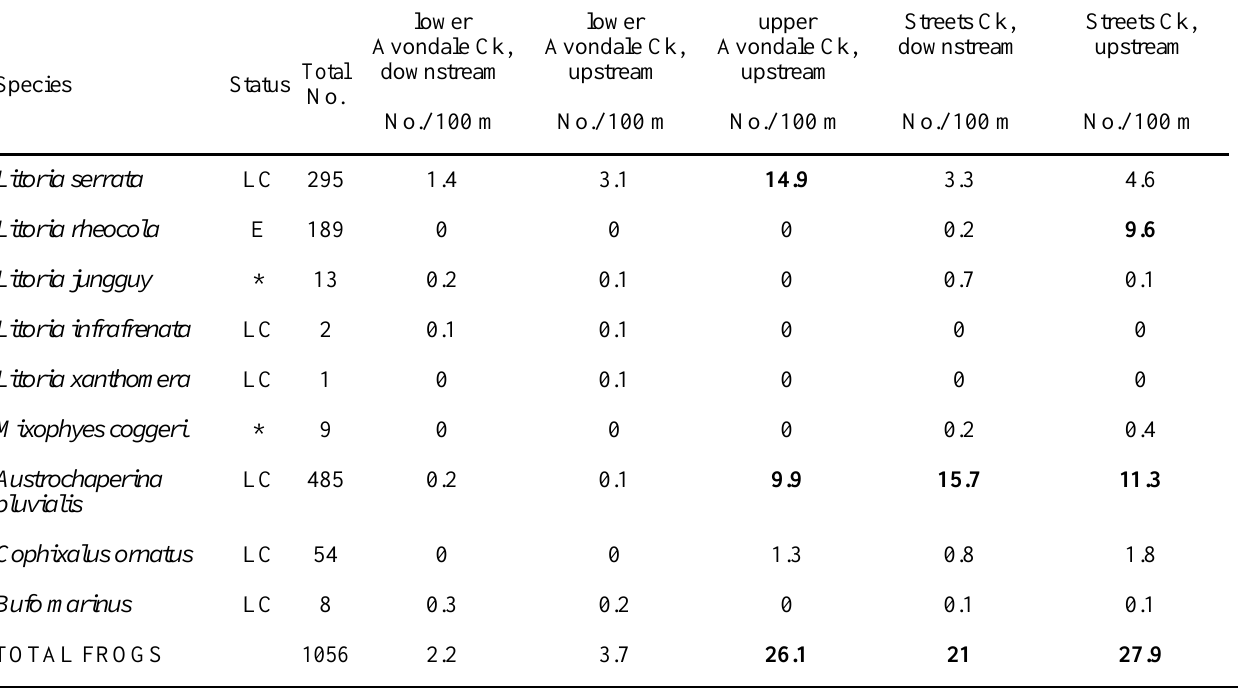
Table 1. Frog abundance on the stream transects. All transects were surveyed six times. Table shows the conservation status of the species; the total number of records for each species across all transects; and the average number of individuals of each species per 100 m on each transect (a standardized measure of abundance). Bolding shows species (or total frogs) recorded at an abundance of approximately 10 individuals or more per 100 m. Status is the Australian EPBC status; categories here are E (Endangered) and LC (Least Concern). Two species are recently described (marked with asterisk) and are common and best considered LC. Litoria serrata was formerly included within L. genimaculata (Richards et al. 2010). lower lower upper Streets Ck, Streets Ck, Avondale Ck, Avondale Ck, Avondale Ck, downstream upstream downstream upstream upstream Total mSpecies Status No./ 100 m No./ 100 m No./ 100 m No./ 100 m No./ 100